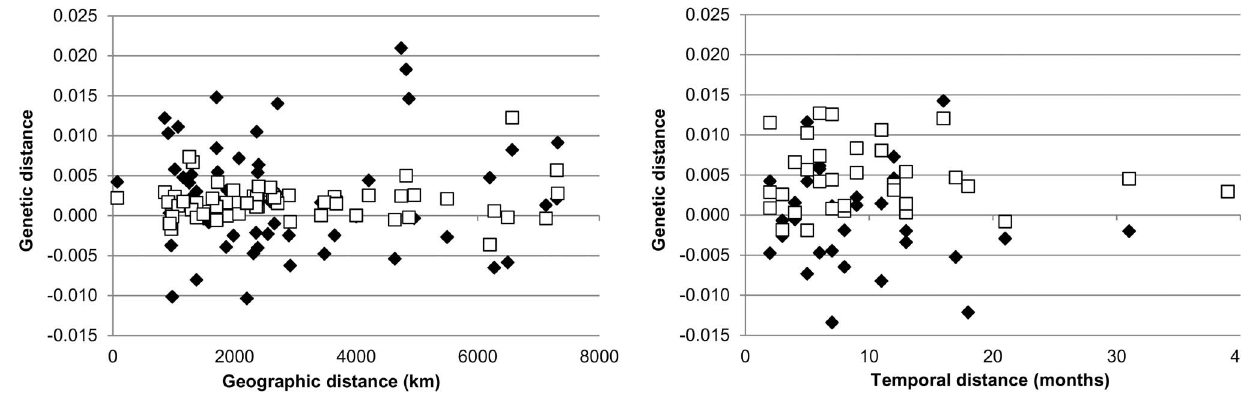
Figure 4. Isolation-by-distance and Isolation-by-time graphs. Graphs showed corrected pairwise genetic distances [ F st/(1 2 F st) for mtDNA and Fst/(1 2 Fst) for microsatellite] plotted as a function of geographic distances ( 4a ) or of time ( 4b ) for Indian Ocean swordfish. Black diamonds are for mtDNA data and white squares for microsatellite data (all were not significant: Mantel tests with p . 0.05).